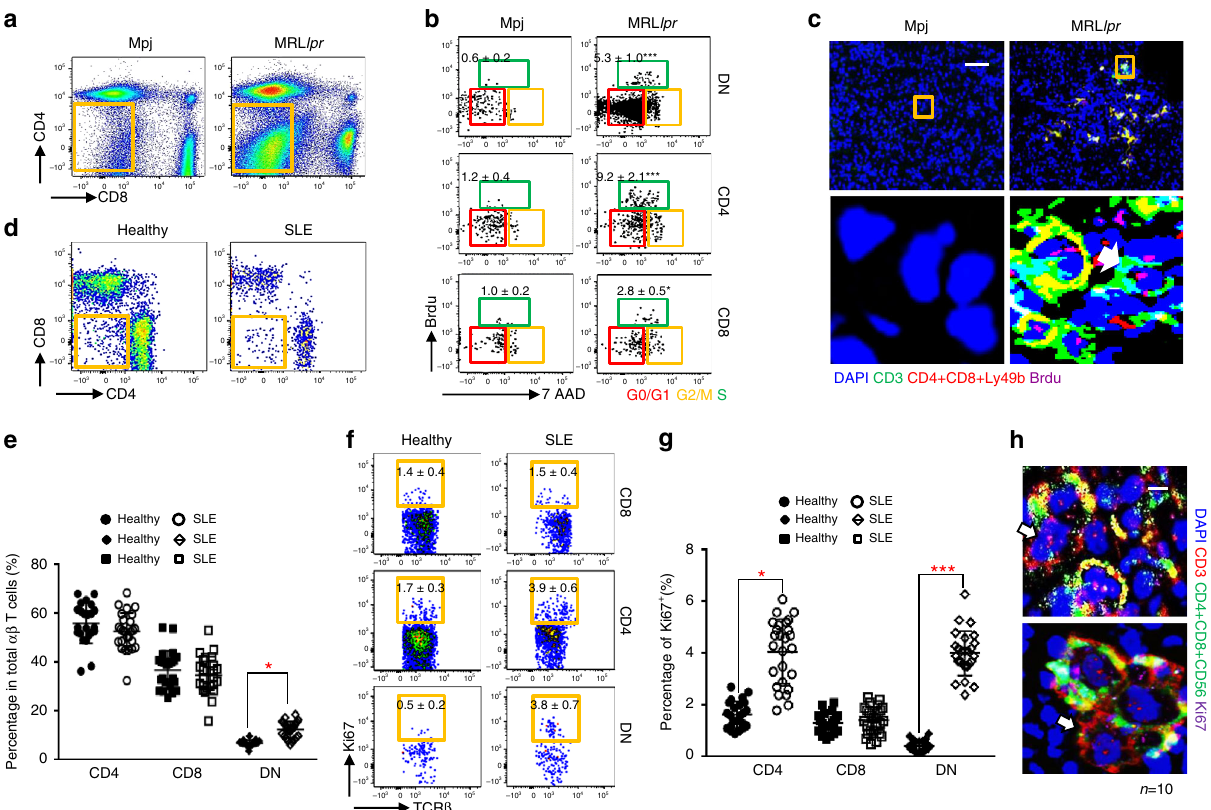
Fig. 6 DN T cells display proliferating or proliferated phenotype. a – c Sixteen week-old female MPJ or MRL. lpr mice were injected i.p. with BrdU (1 mg/ mouse) 12 and 0.5 h prior to the euthanasia. Data represent the mean ± SEM (* P < 0.05, *** P < 0.005 vs. control, Student ’ s t test; n = 6 mice per group). a Flow cytometry analysis of different subset T cells from indicated mouse spleens. b Flow cytometry analysis of cell cycle phases of different subset T cells from indicated mouse spleens (gated in CD3 + TCR β + Ly49b − ). BrdU incorporation is used for characterization of cells that are actively synthesizing DNA and 7-AAD staining intensities were further applied to de fi ne related cell phase in the cell cycle (G0/G1, G2/M, or S phases). c Representative immuno fl uorescent staining of BrdU + (magenta) DN T cells (green) in kidneys from indicated mice. Upper: magni fi cation, ×10. Scale bar: 100 µ m; Lower: digitally magni fi ed views of the boxed areas in the upper panels. d – g n = 23 for healthy controls and n = 26 for SLE patients. d Representative fl ow cytometry analysis of CD4, CD8, and DN T cells in total T cells in PBMC from either healthy subjects or SLE patients. e Scatter plots show the percentage of CD4, CD8, and DN T cells in total circulating T cells (gated in CD3 + TCR β + CD56 − ) from either healthy controls or SLE patients. f Flow cytometry analysis of Ki67 + CD4, CD8, and DN T cells in total T cells from PBMC from healthy controls or SLE patients. g Scatter plots show the quantitation of Ki67 + CD4, CD8, and DN T cells of human PBMC (gated in CD3 + TCRv β + CD56 − ) from either healthy controls or SLE patients. h Representative immuno fl uorescent staining of Ki67 + (magenta) DN T cells (green) in kidney biopsy samples from patients with SLE. Upper: magni fi cation, ×100. Scale bar: 5 µ m; Lower: digitally magni fi ed views of the boxed areas in the upper panels. n = 10. Data represent the mean ± SEM (* P < 0.05, *** P < 0.005 vs. indicated control, Student ’ s t Importantly, marginal zone macrophage depletion accelerated this age-associated enrichment, suggesting that the dominance of V β 5 and V β 8 might be a consequence of selective expansion driven by self-antigens (Fig. 7a). Of note, T-cell receptor (TCR) beta chain sequence analysis revealed a higher proportion of top ten clonotypes in DN T cells from MRL.lpr mouse which con- fi rmed the selective expansion of some clone types of DN T cells (Supplementary Table 1, Supplementary Fig. 19). Consistently, increased clonal space occupation by V β 5 clonotypes was also observed in DN T cells from MRL.lpr mouse (Supplementary Fig. 20, Supplementary Table 2). We next utilized human per- ipheral blood mononuclear cells (PBMCs) isolated from SLE patients and healthy donors, and con fi rmed the preferential usage of V β 5 and V β 8 by CD8 and DN T cells from SLE patients but not healthy donors (Fig. 7b), further suggesting the possibility that DN T cells develop from self-antigen-stimulated CD8 T cells in SLE.